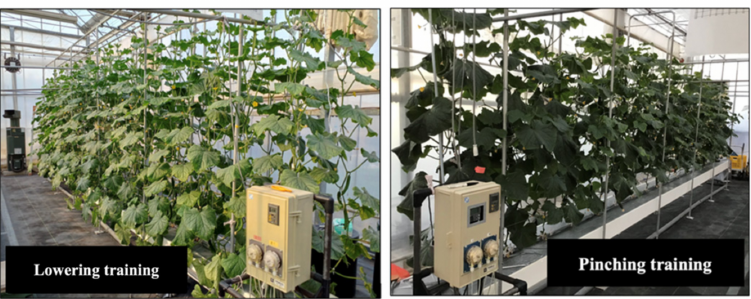
Figure 10. Pictures of cucumber grown using pinching and lowering training